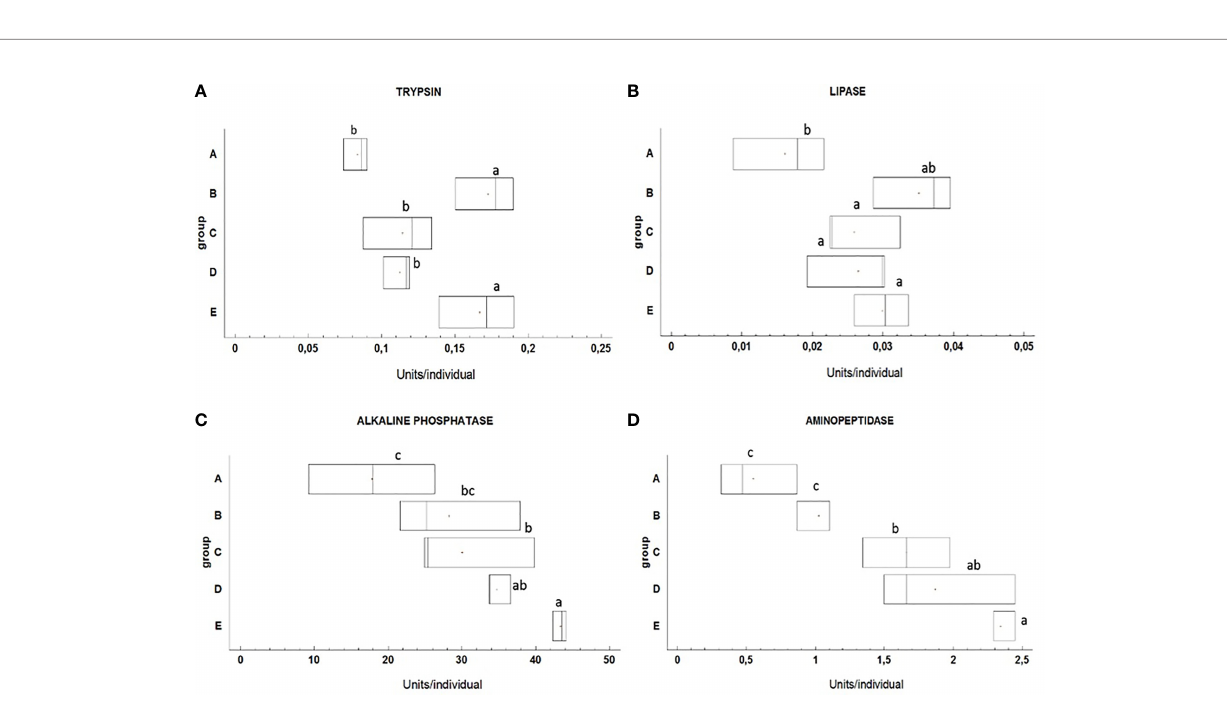
FIGURE 4 | The activities of trypsin (A) , lipase (B) , alkaline phosphatase (C) and aminopeptidase (D) in pikeperch larvae at the end of experimental period (17 DPH) at different feeding regimes ( n =3 pools of 15 larvae per group). Different letters indicate signi fi cant differences among groups ( p <0.05). Box limits correspond to upper and lower quartiles, horizontal bar to the median, and points show mean values.